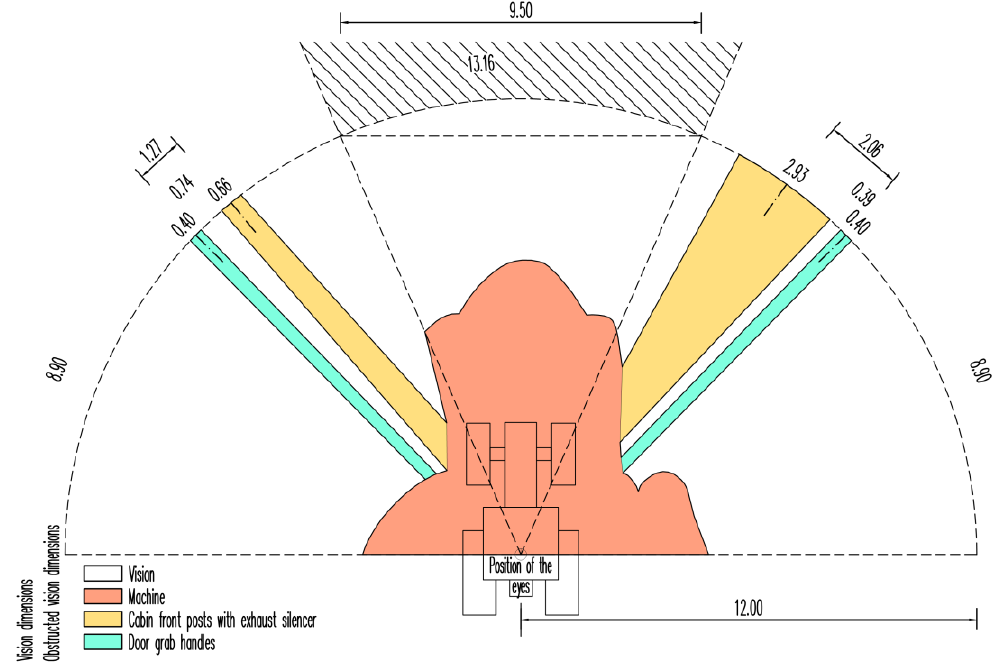
Figure 7. Semi-circular vision to the front of agricultural tractor driver determined by the method of measuring the cast of shade by two light point sources. Note: Dimensions are in m.